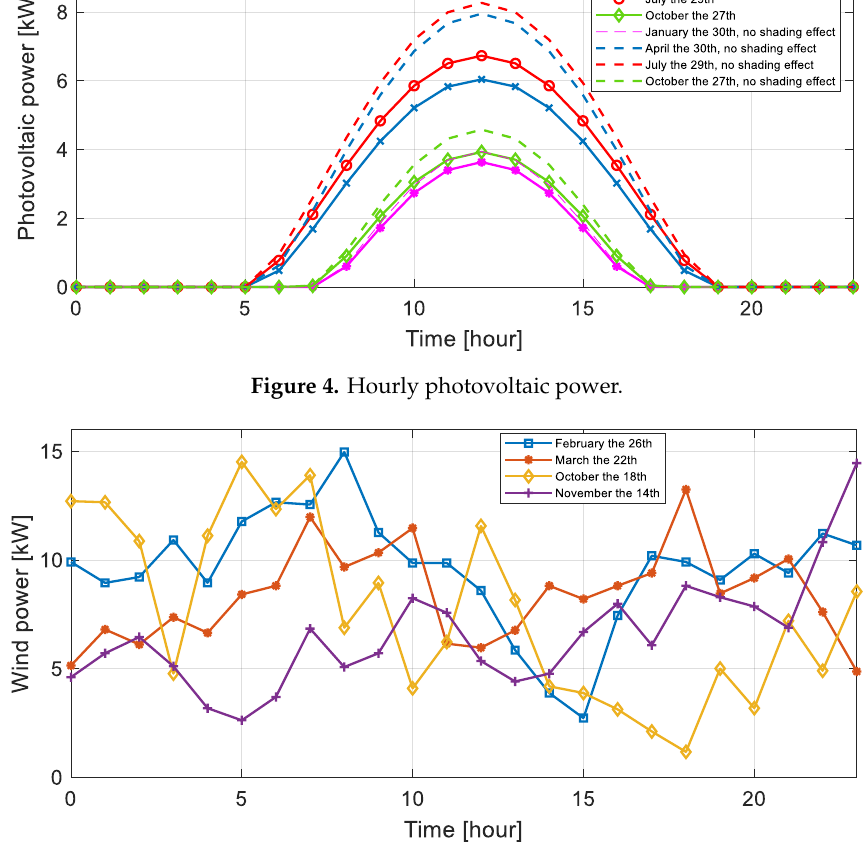
Figure 5. Hourly wind turbine power.